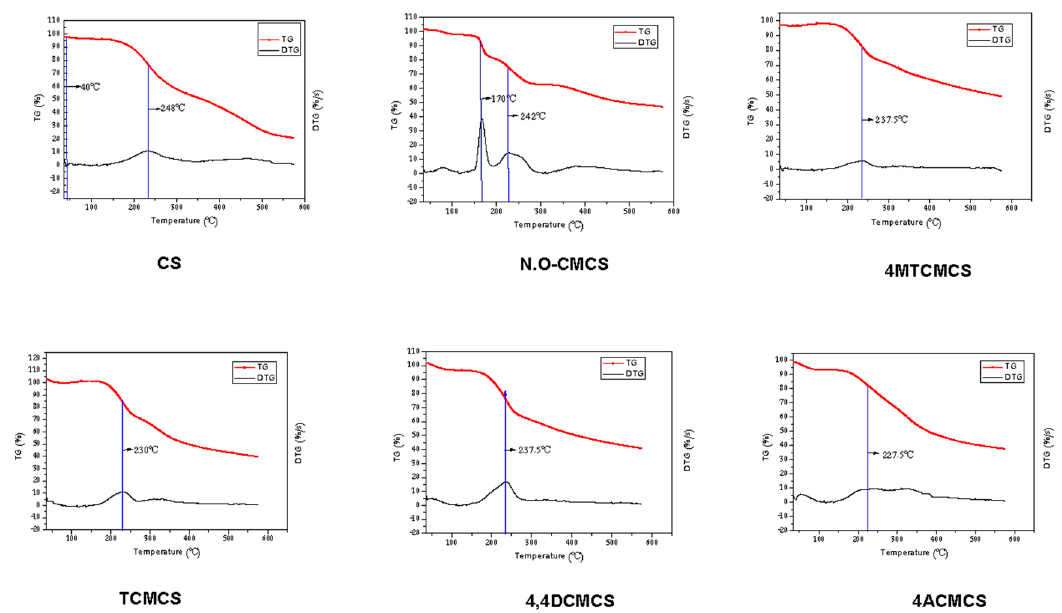
Figure 4. TGA thermogram curves of CS, N, O-CMCS, and Carboxymethyl chitosan containing thiourea salts.